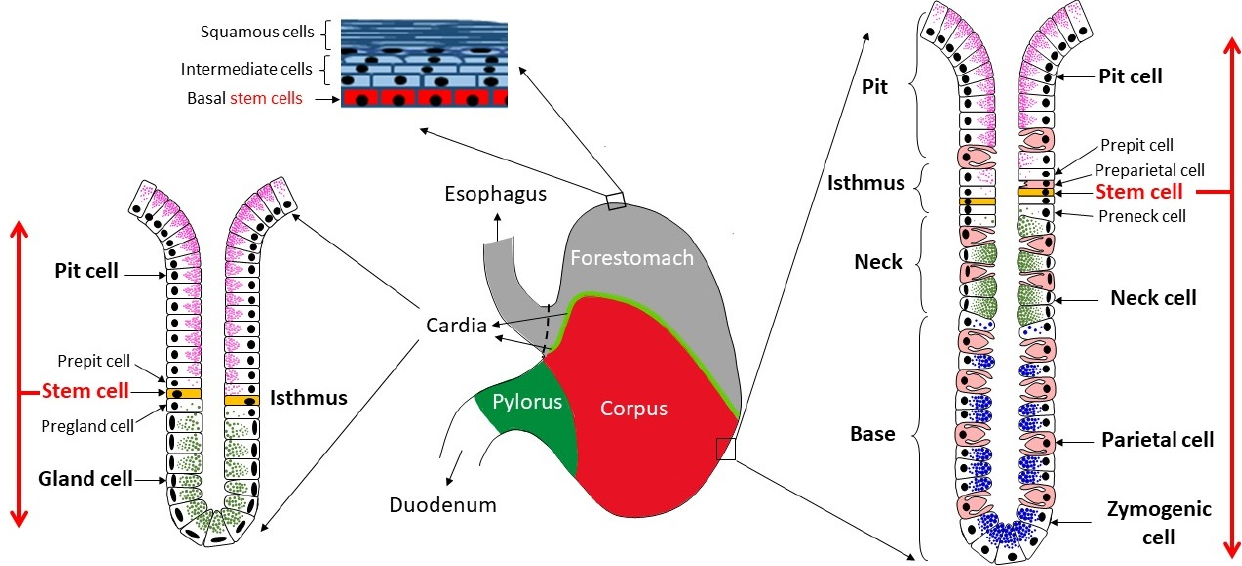
Figure 1. Diagram representing the mouse stomach regions (forestomach, cardia, corpus, and pylorus) with the stratified epithelium of the forestomach and the glandular epithelia of the cardia and the corpus. The progenitor/stem cells in the basal layer of the forestomach and near the middle (isthmus) of the cardiac and corpus glands give rise to squamous cells, mucus-secreting pit, and gland/neck cells, acid-secreting parietal cells, and pepsinogen-secreting zymogenic cells. The red arrows indicate the bi-directional migration pathways of the stem cell progenies.